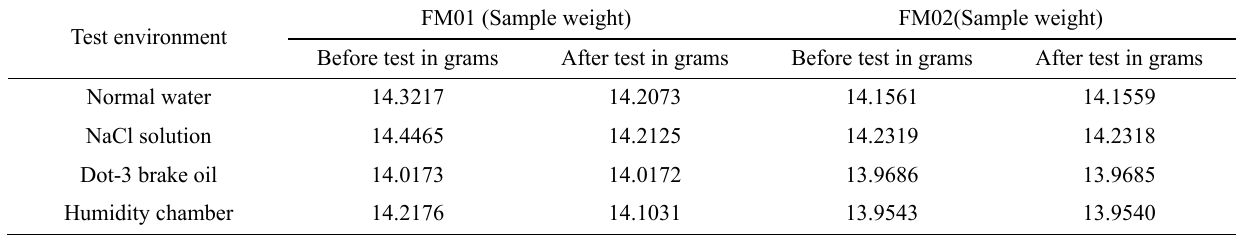
Fig. 14 3D surface profiles of the dyno tested (a) FM01 composite and (b) FM02 composite. Table 4 Change in weight before and after various test